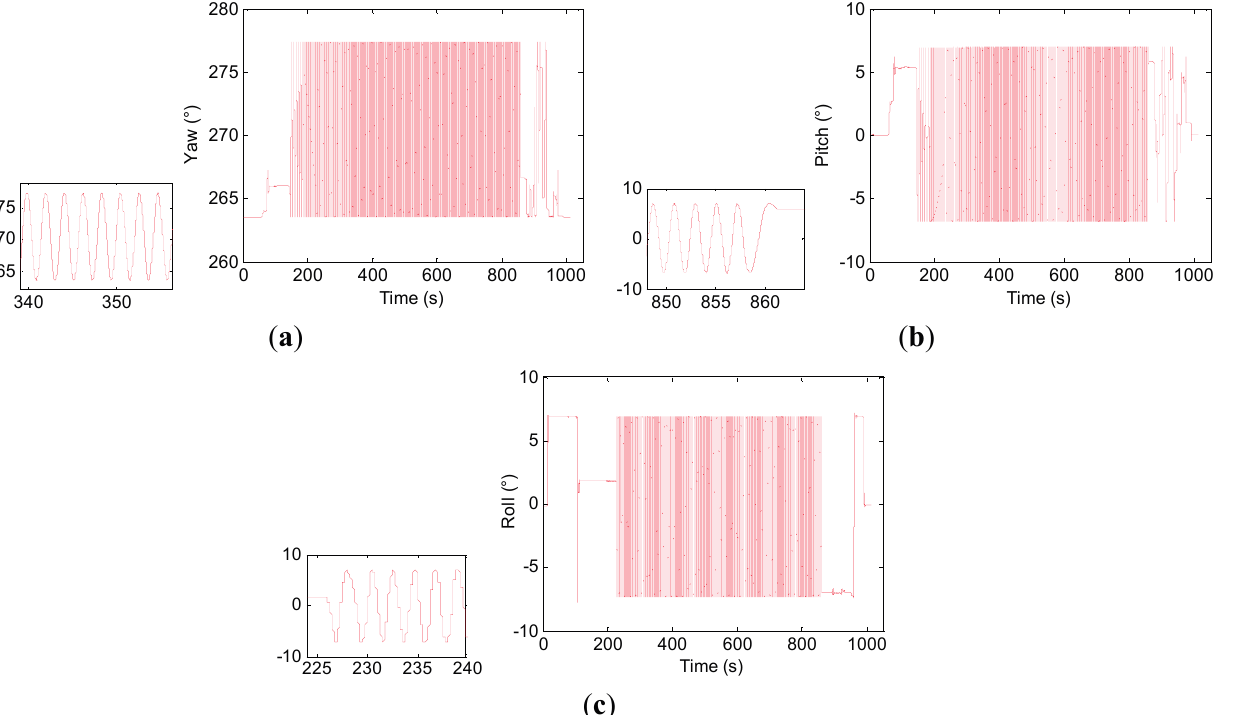
Figure 6. LINS attitudes output during wobbling test (2000 Hz attitude update rate). ( a ) Yaw, ( b ) Pitch, ( c )